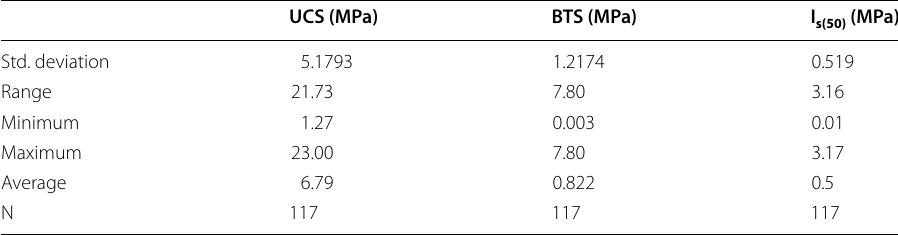
UCS uniaxial compressive strength (MPa), BTS tensile strength (MPa), I s(50) point load index (MPa)